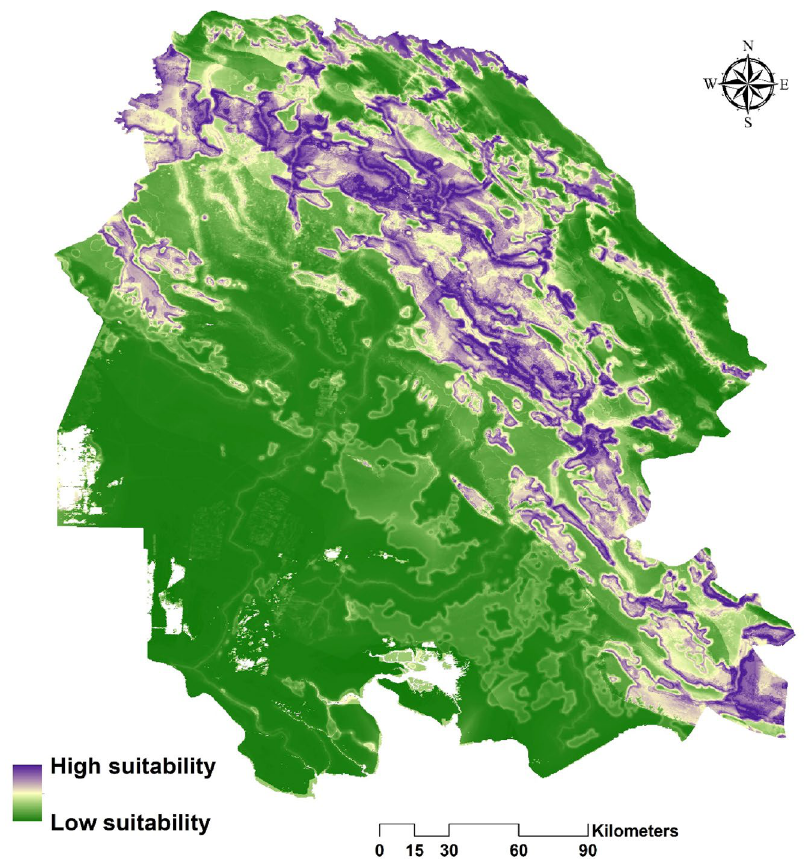
Figure 3. Ensemble habitat suitability map for the striped hyaena in the study area based on the four optimal models of GLM, MaxEnt, RF, and GBM. ArcGIS software version 10.1 (https:// www. esri. com/ en- us/ arcgis/ produ cts/ arcgis- pro/ resou rces) was used to generate the